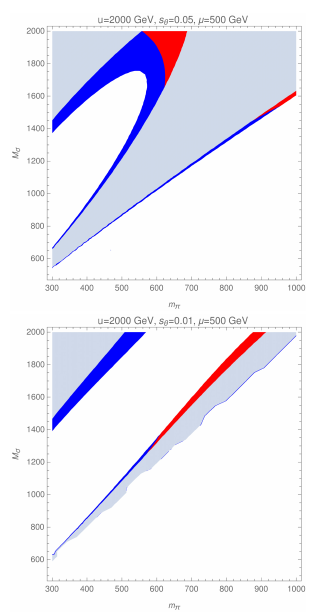
Figure 2. Results of numerical solution of kinetic equations(2,3) in a phase diagram in terms of M ˜ σ and m ˜ π parameters, for details on color codes see the text. For details on plot parameters see section